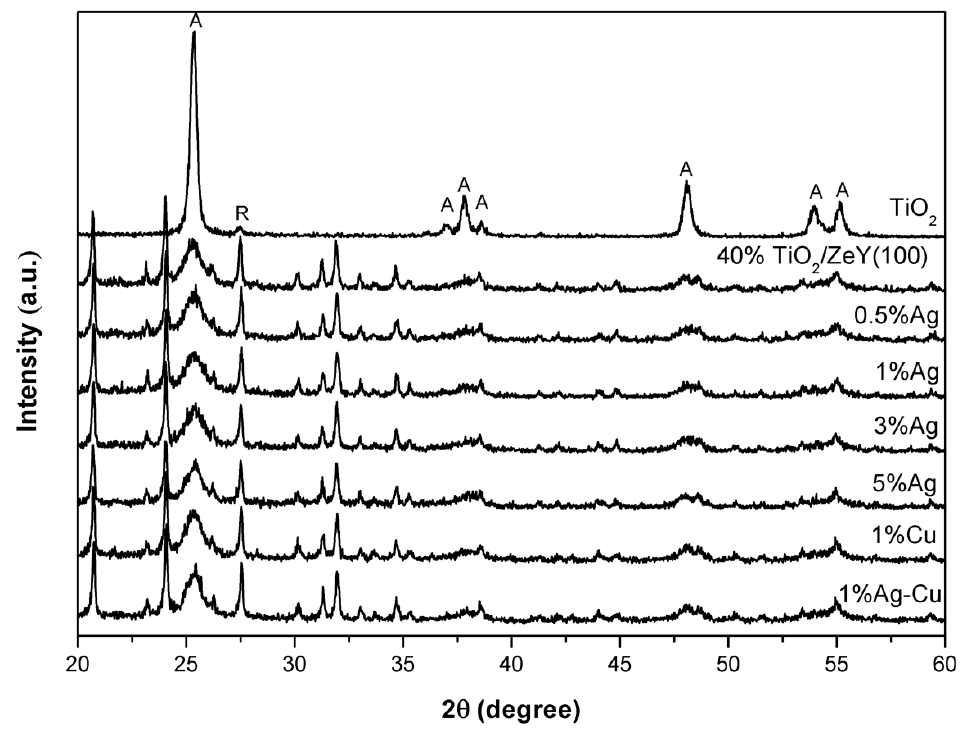
Figure 4. XRD patterns of TiO 2 , TiO 2 (40%) / ZeY, Ag-TiO 2 (40%) / ZeY (at di ff erent wt. %), 1 wt. % Cu-TiO 2 (40%) / ZeY, and 1 wt. % Ag-Cu-TiO 2 (40%) / ZeY.